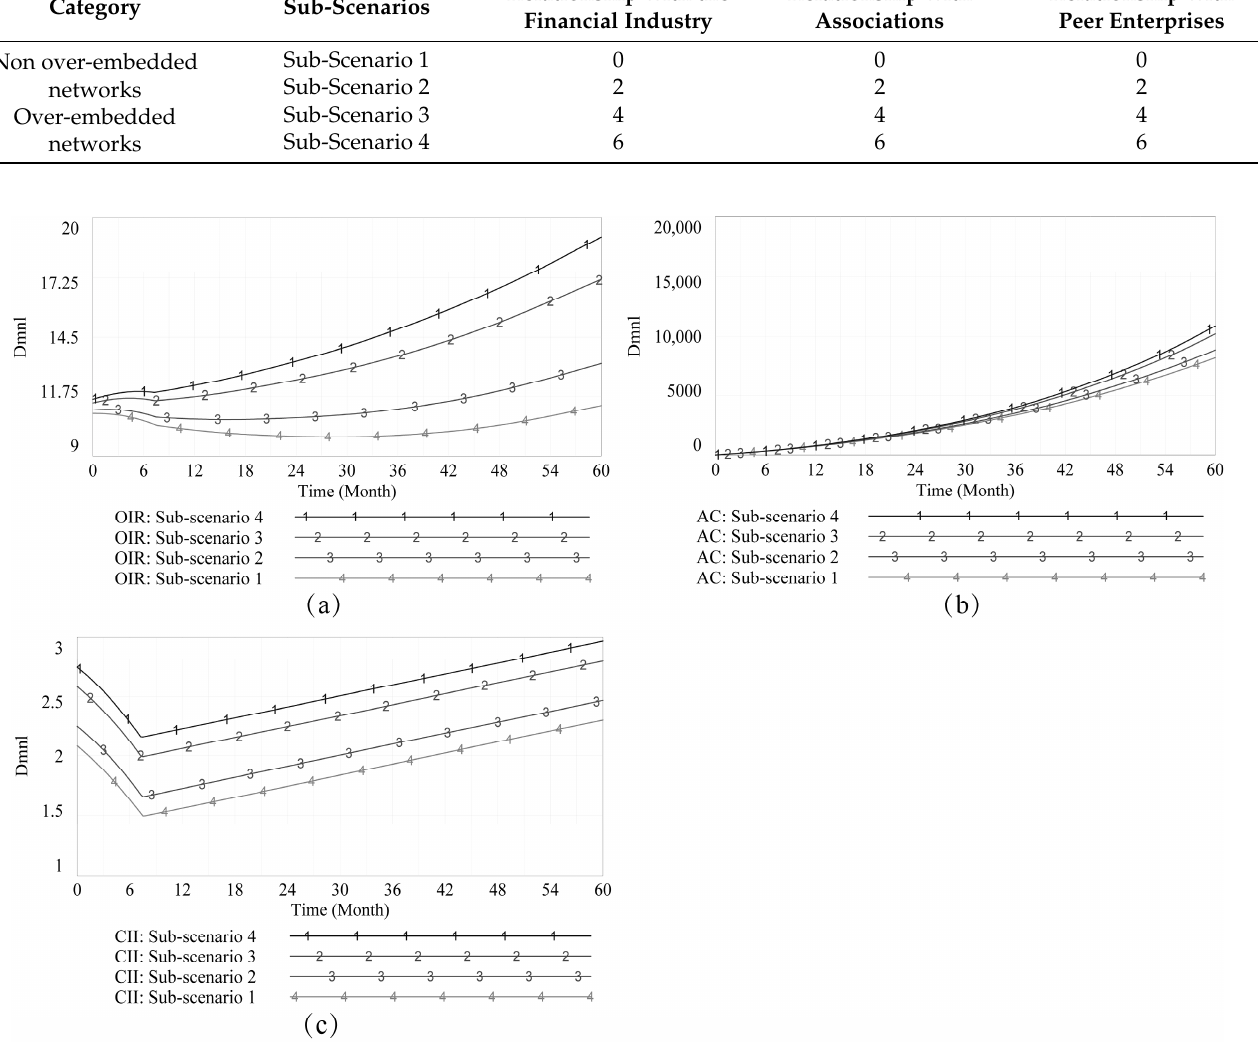
Figure 7. Evolution of OIR, AC, and CII under the enterprise network relationship scenarios.